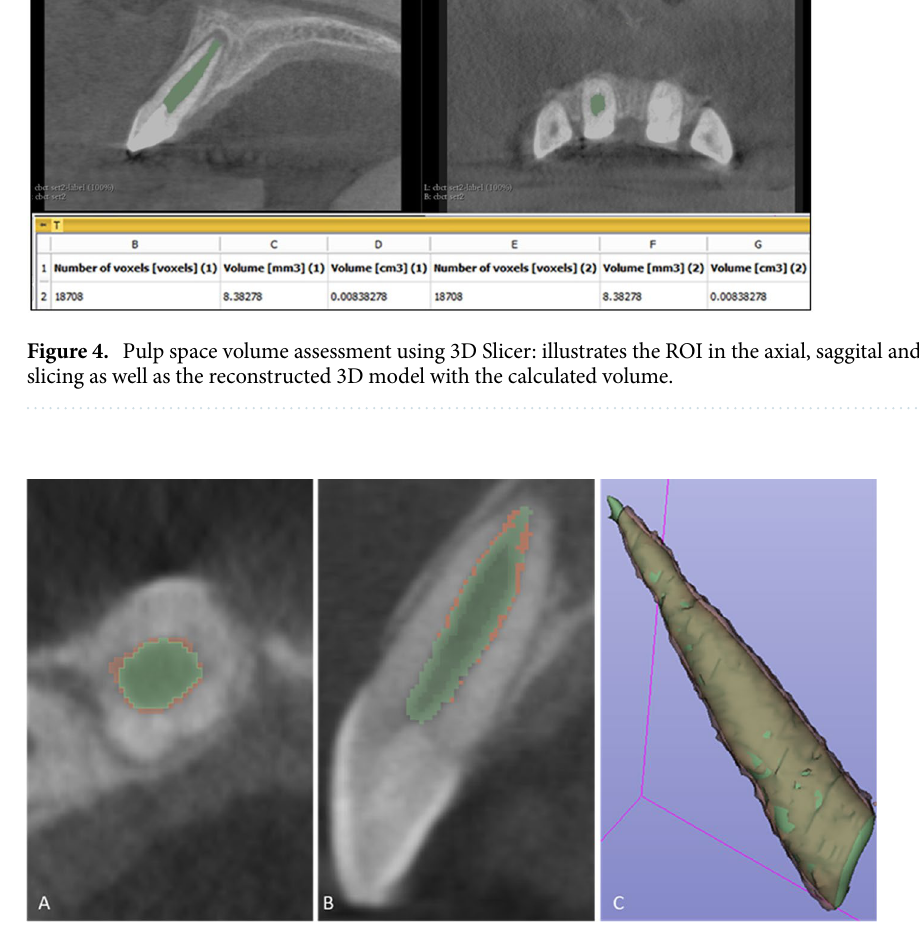
Figure 5. Voxel-based superimposition. Axial slice ( A ), sagittal slice ( B ) and 3d reconstruction ( C ) showing post pulp volume segmentation (green) superimposed over the pre pulp volume segmentation